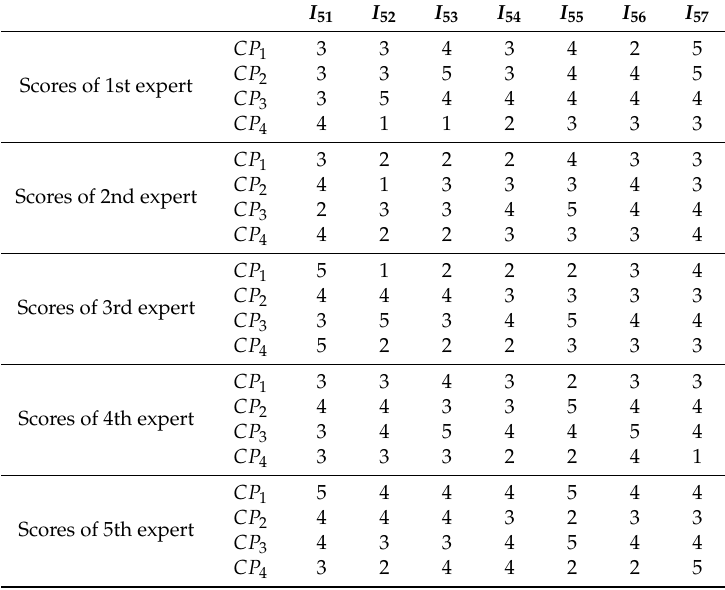
Table A14. Scores of the status level of the closing process index.